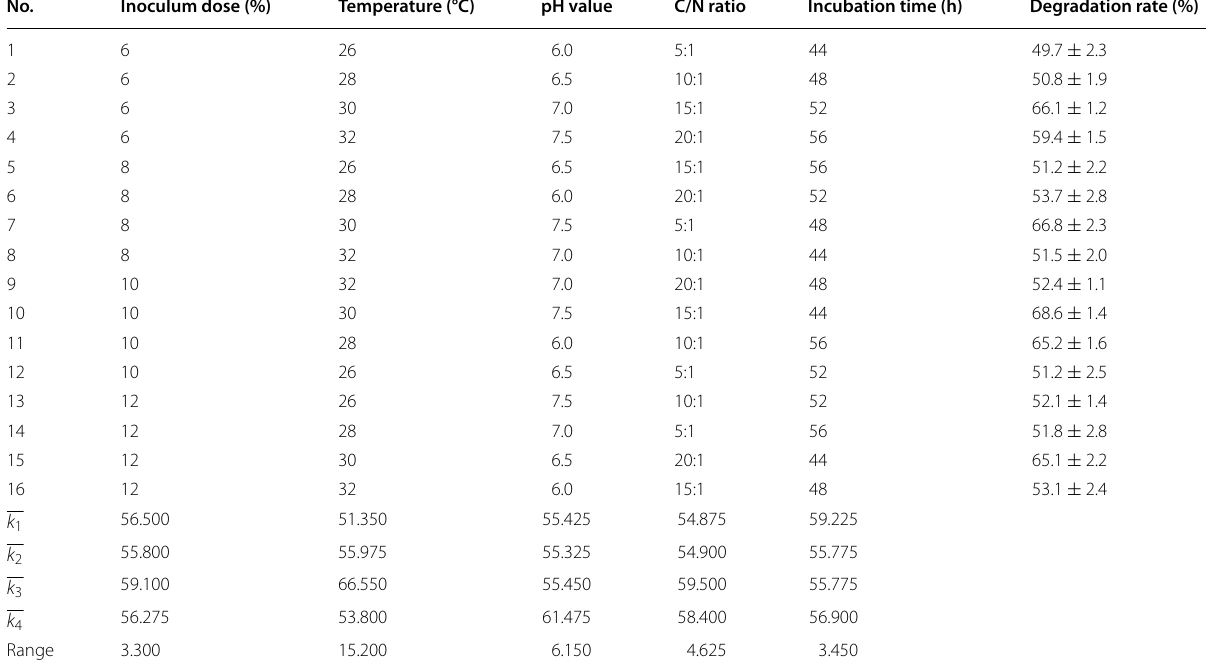
The degradation rates are presented as mean